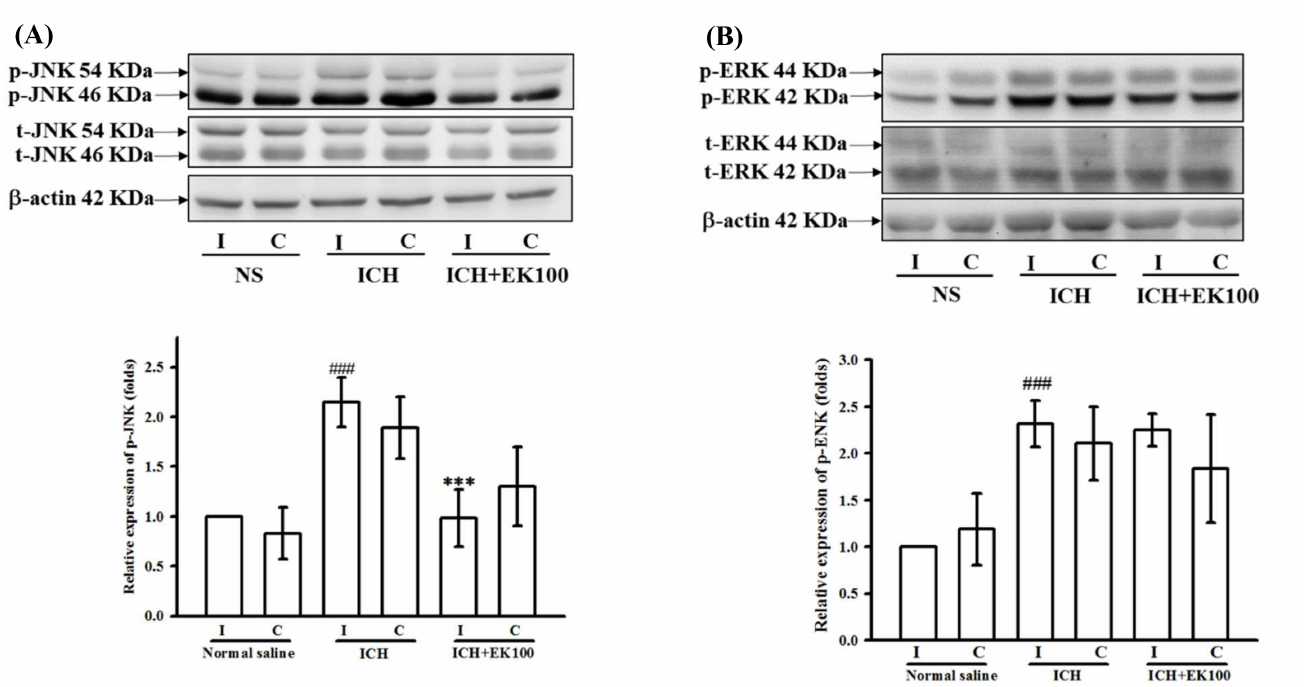
Figure 8. Effects of EK100 on the cerebral levels of p-JNK and p-ERK MAPK proteins after ICH. C57BL/6 mice were administered vehicle or EK100 with an oral dosage of 30 mg/kg at 30 min after the intrastriatal injection of 0.02 U collagenase to induce ICH. Brain slices (3 mm) were obtained at 24 h after ICH, and their ipsilateral (I) and contralateral (C) regions were analyzed for the expression of p-JNK ( A , n = 4) and p-ERK ( B , n = 4) proteins by Western blots. The relative changes (folds) were represented as the mean ± SD. ### p < 0.001 compared with ipsilateral NS-intrastriatal injected with vehicle treatment group; *** p < 0.001 compared with ipsilateral collagenase-intrastriatal injected with vehicle treatment group